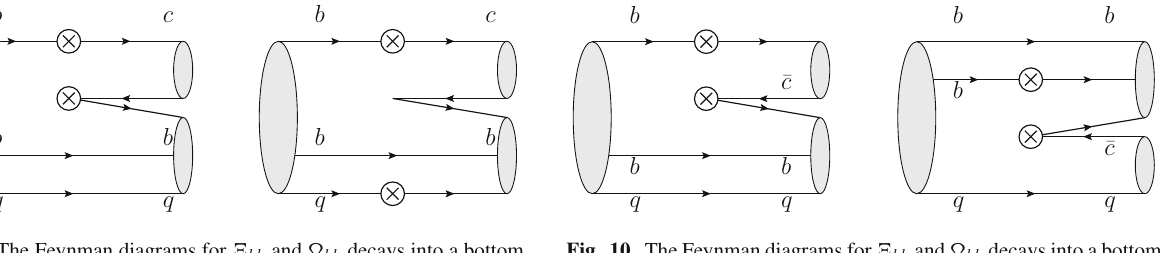
Fig. 10 The Feynman diagrams for (cid:2) bb and (cid:5) bb decays into a bottom baryon and an anticharmed meson for the b → u ¯ cs transition. For the transition b → u ¯ cd one requires the interchange of 2 ↔ 3 in the subscripts, and V cs replaced by V cd